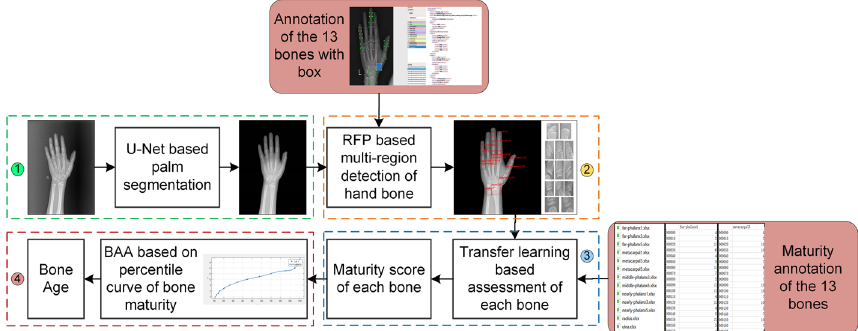
Fig. 1 Illustration of the proposed method: (1) the U-Net module completes image preprocessing and palm segmentation; (2) fine-grained small ROI detection based on recursive feature pyramid. (3) Maturity of each bone assessment based on transfer learning. (4) Bone age calculation based on the percentile curve of bone